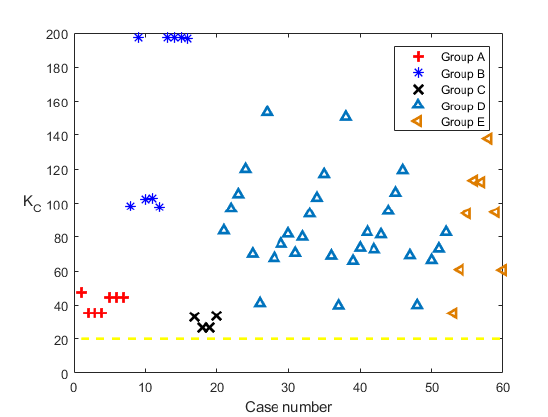
Figure 7. Keulegan–Carpenter number, K C , for all 60 experimental cases summarized in Table 1 with the dashed line indicating the threshold value K C = 20. Group A: Huang et al. [29]. Group B: Koftis et al. [30]. Group C: Dubi and Tørum [31]. Group D: Anderson et al. [32]. Group E: Sánchez-González, Sánchez-Rojas and Memos [33]. See Table 1 for the experimental conditions of each